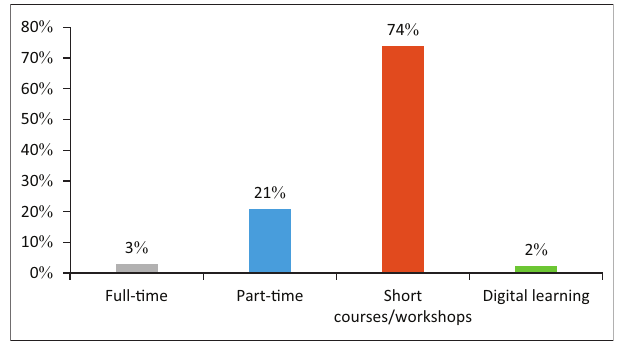
FIGURE 5: Programme for cleft lip/palate/craniofacial deformities